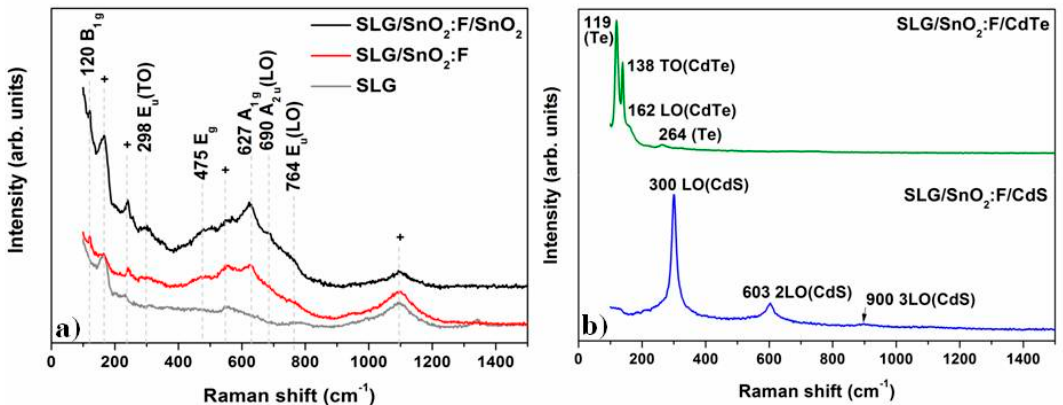
Figure 4. Raman spectra for the samples; ( a ) SnO 2 sample and the substrate and ( b ) CdS and CdTe samples.